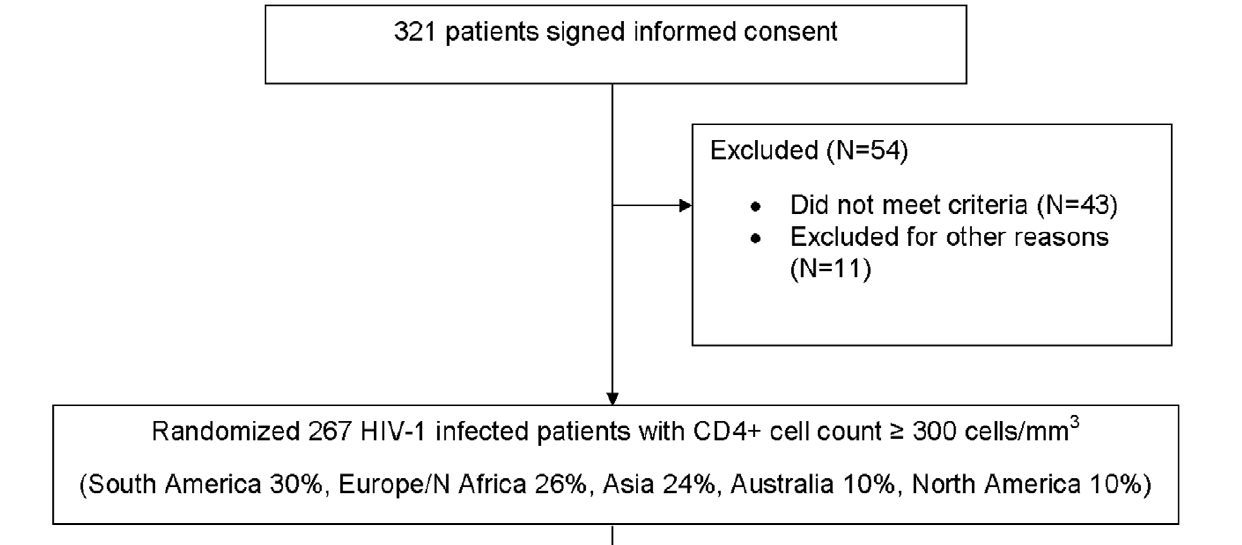
Figure 1. STALWART study design and CONSORT flow diagram.